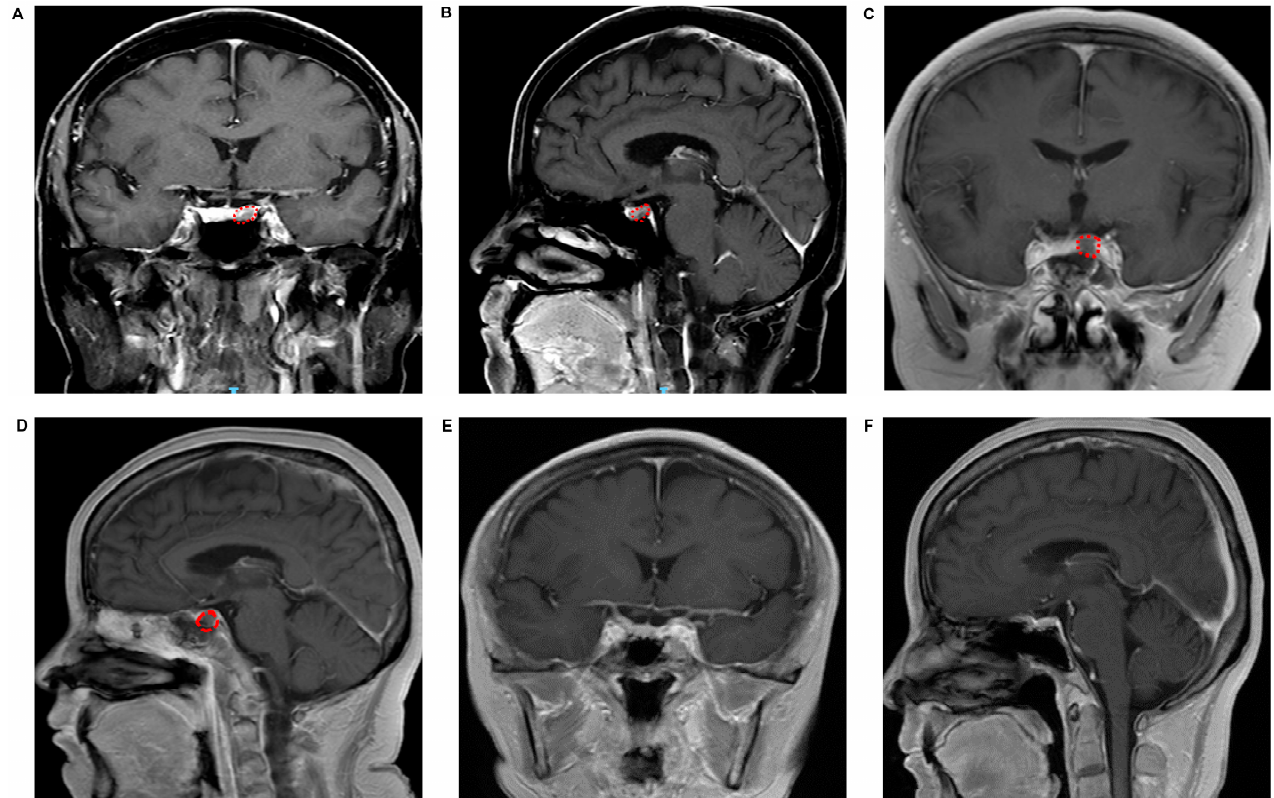
Figure 1. Preoperative and postoperative MRI. ( A , B ) Coronal and Sagittal MRI scans show a microadenoma adjacent to the left cavernous sinus. ( C , D ) Coronal and Sagittal MRI scans taken 2 days after surgery, indicating that the tumor was removed completely. ( E , F ) Coronal and Sagittal MRI scans taken 3 years after surgery, indicating no recurrence.